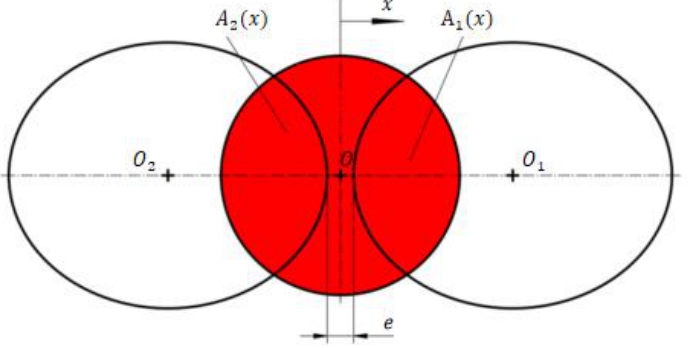
Figure 2. Projection of the upper surface of the receiver.